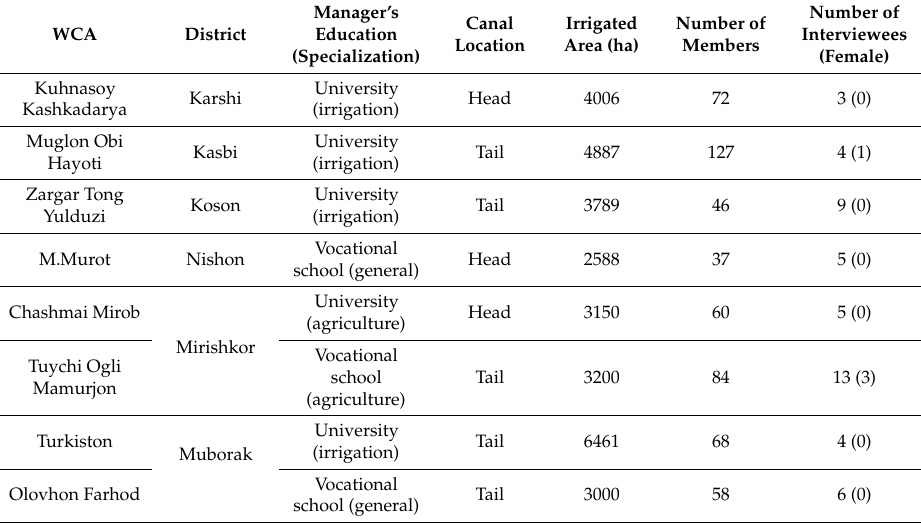
Table 1. WCAs selected for the